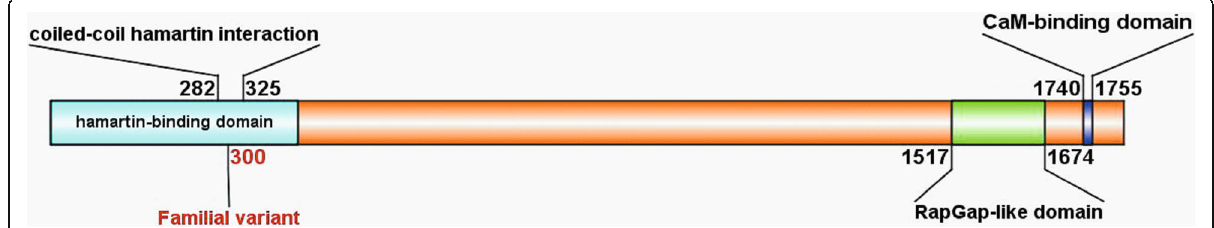
Fig. 3 Biochemical structure of tuberin. TSC2 c.899G > T variant resulting a substitution from Glycine to Valine, is located in the coiled-coil harmartin interaction region within N terminus of tuberin (number represents the location of amino